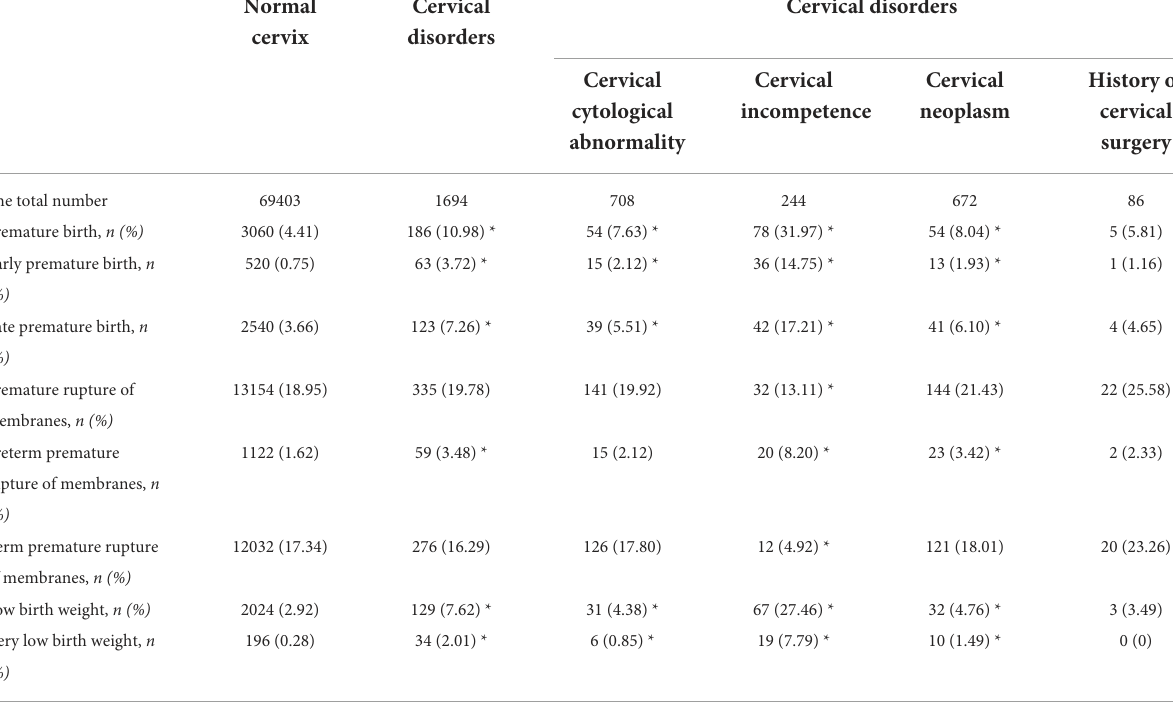
TABLE 2 Associations between different classifications of cervical disorders and adverse outcomes.